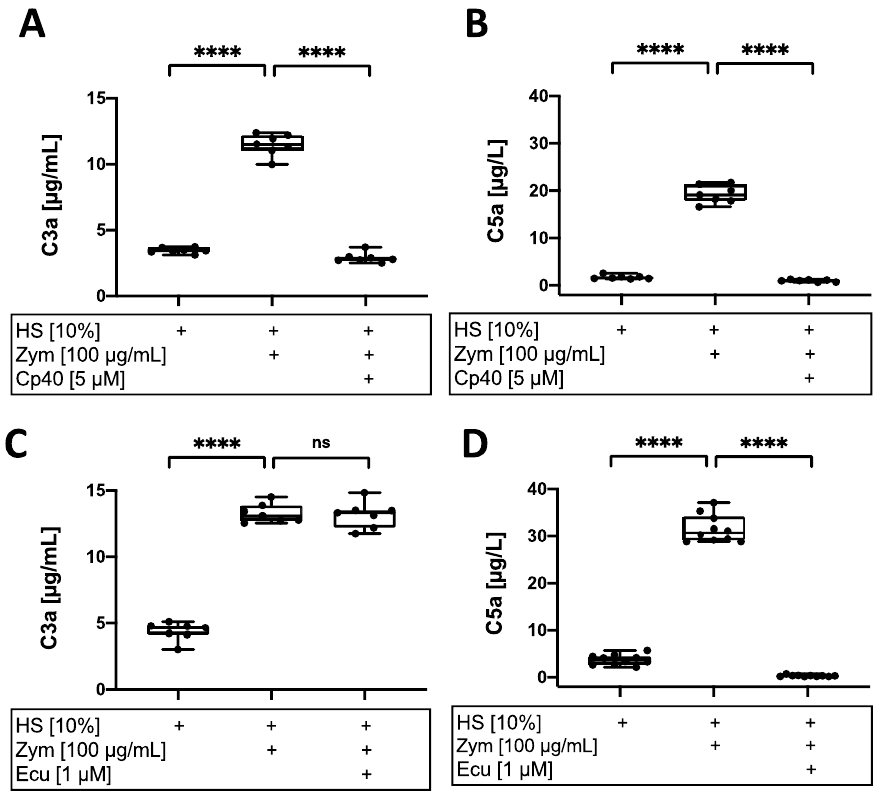
Figure 4. Effect of complement inhibition on anaphylatoxin generation. Analysis of ( A , C ) C3a (µg/mL) and ( B , D ) C5a concentrations (µg/L) in annulus fibrosus (AF) cell culture supernatants after 24 h of stimulation with 10% human serum (HS) alone or together with zymosan (100 µg/mL; Zym) with or without supplementation of ( A , B ) Cp40 (5 µM) or ( C , D ) eculizumab (1 µM; Ecu). The results are presented as box-and-whisker plots with median ± interquartile ranges ( n = 6 – 10 donors per group). Significant differences are depicted as: **** p < 0.0001; ns: not significant. One-way ANOVA was used.